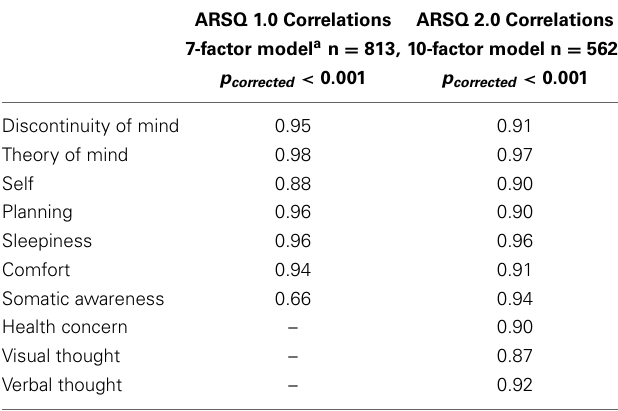
Table 1 | Correlation between estimated CFA factor scores and scores derived from averaging the item responses within each